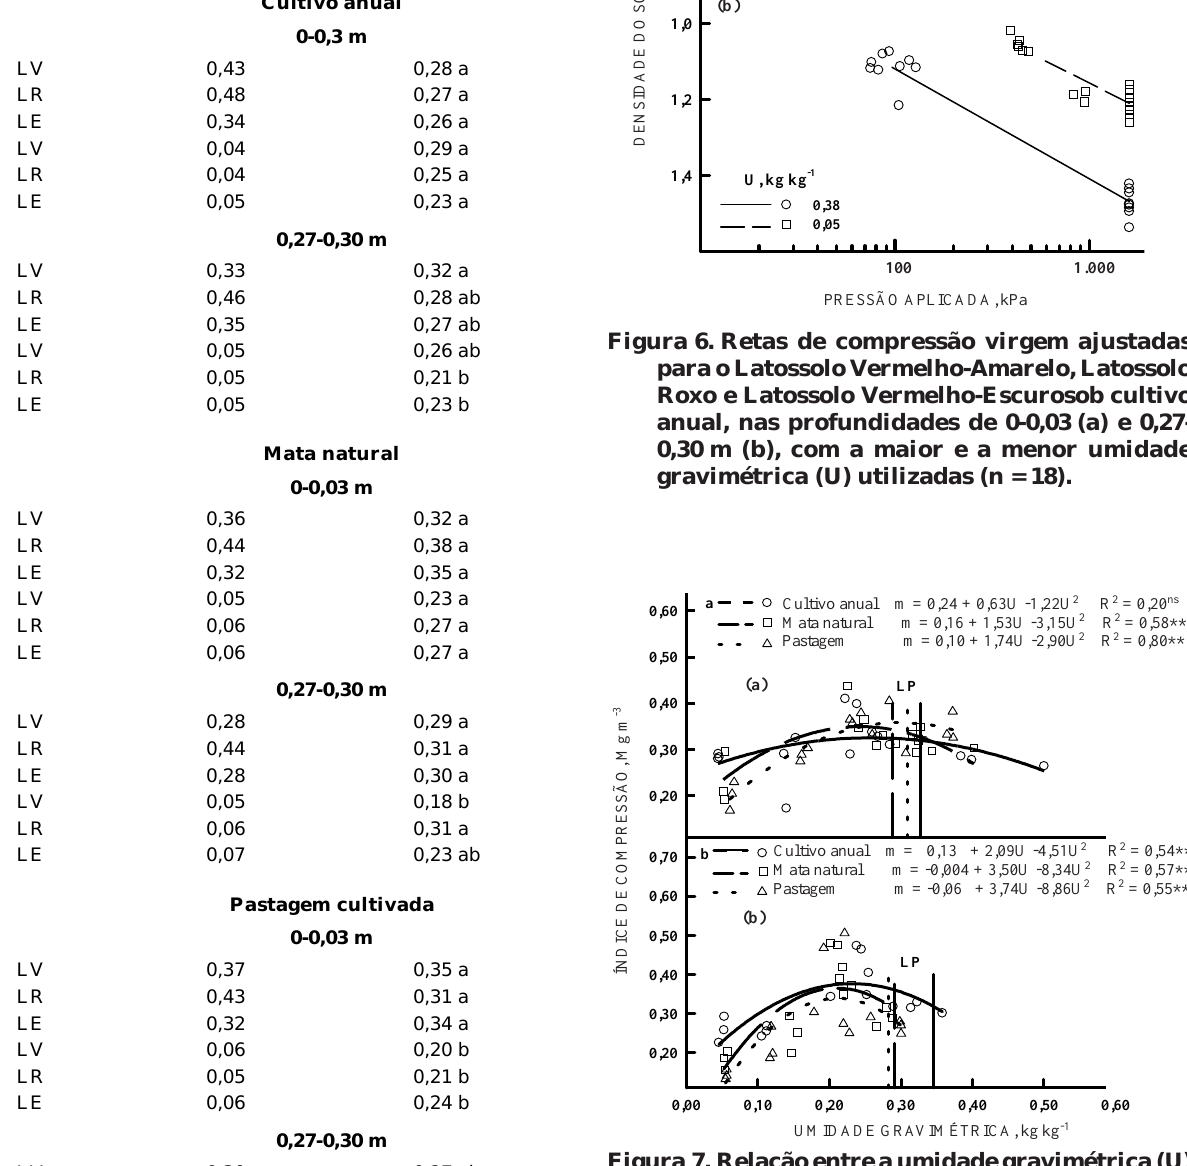
Figura 7. Relação entre a umidade gravimétrica (U) e o índice de compressão (m) para o Latossolo natural e pastagem cultivada, nas profundidades de 0-0,03 (a) e 0,27-0,30 m (b), com 15 repetições (a linha vertical representa o limite de plasticidade (LP), com três repetições). *, **, ns significativos a 5 e 1% e não-significativo,